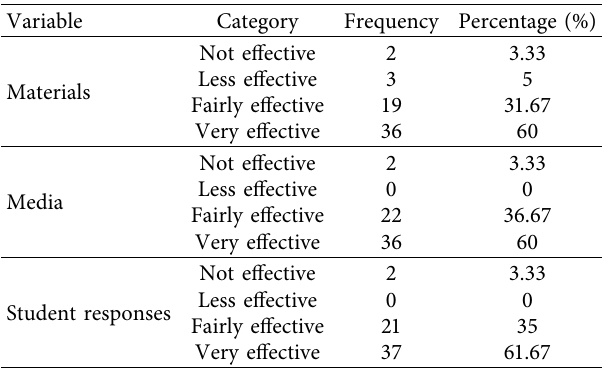
Table 8: Student